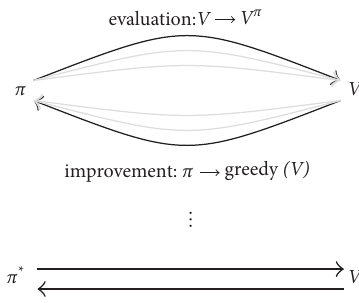
Figure 9: Learning by policy iteration method.